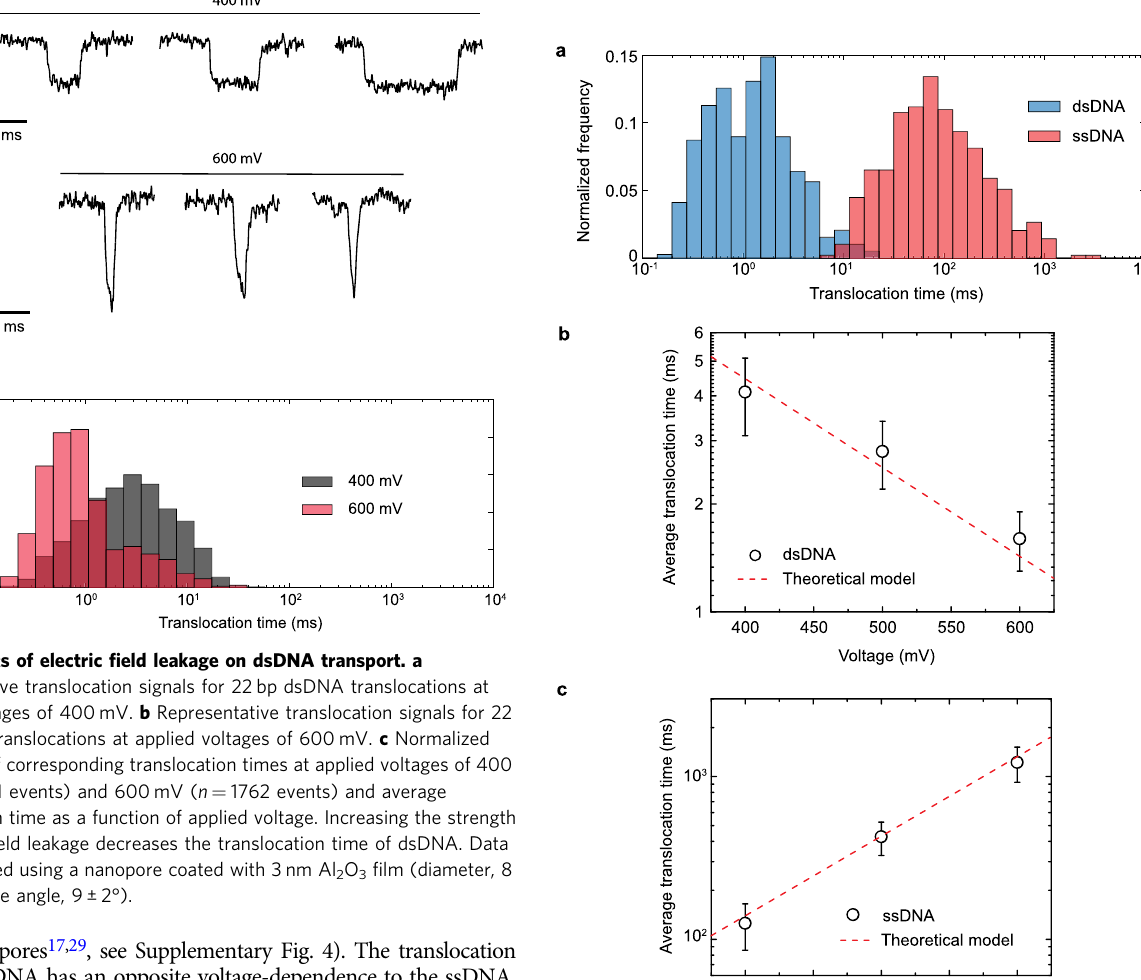
W and W * are given by Eqs. (3) and (4), respectively, with τ for a charge per nt of 0.1e and a length per nt of 0.64 nm). Error bars in the fi gures represent the standard deviation between independent experiments.